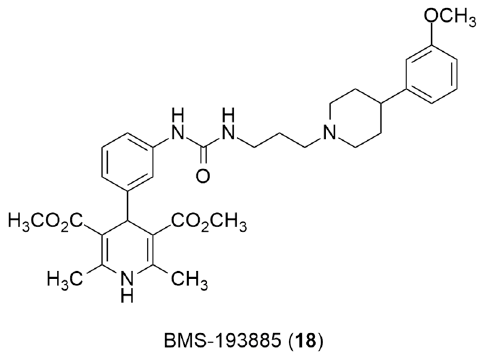
Figure 7. Chemical structure of Y 1 receptor antagonist BMS-193885( 18 ).